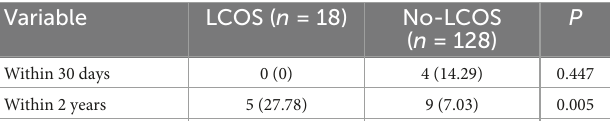
TABLE 5 Re-admission in patients with LCOS.